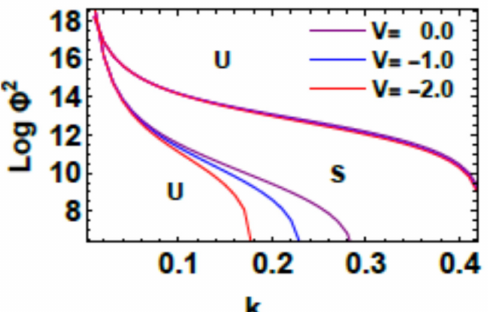
Figure 21. Variation of Log Φ 2 with k to depict the contribution of Equations (53) and (54) along with data A for different values the parameter V